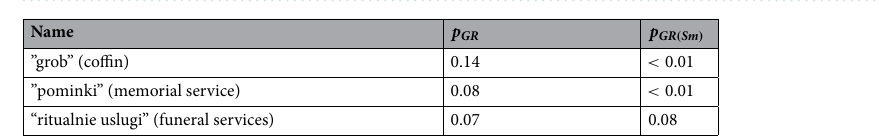
Figure 7. The visualization of pairwise comparisons between the standardized mortality records and the standardized Google Trends for ( A ) ”grob” i.e. coffin, ( B ) ”pominki” i.e. memorial service and ( C ) “ritualnie uslugi” i.e. funeral services key phrases. The standardized mortality values are presented as blue dots, while the standardized search data are presented as brown squares. The corresponding smoothers are presented as cyan and dark orange lines.